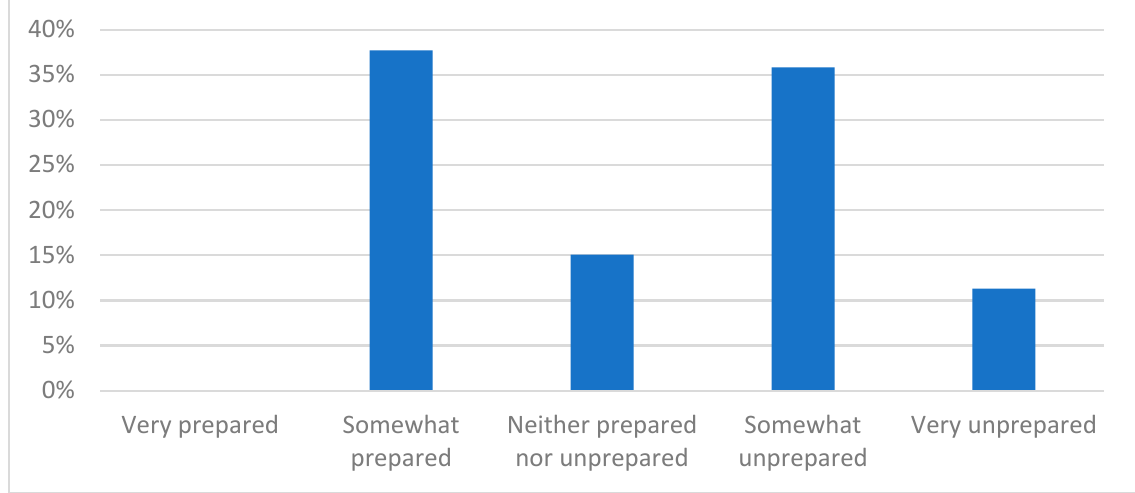
Figure 8. How prepared are shipping companies in meeting the IMO 2021 requirements and consequently addressing cyber security? (Asia and Europe).